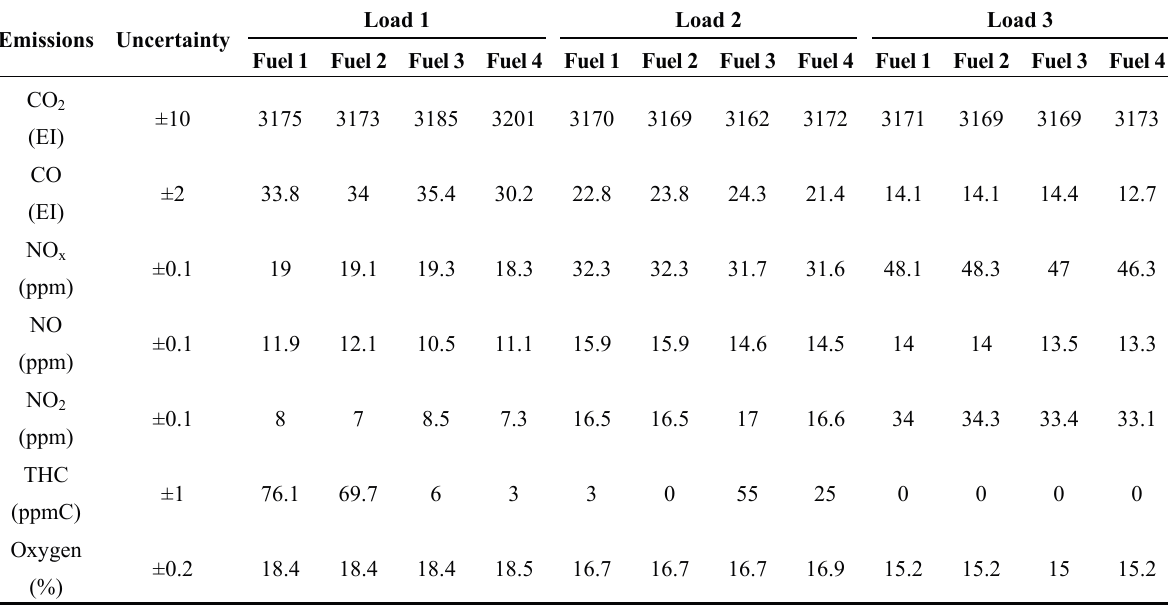
Table 3. Gaseous emissions analysis at all three